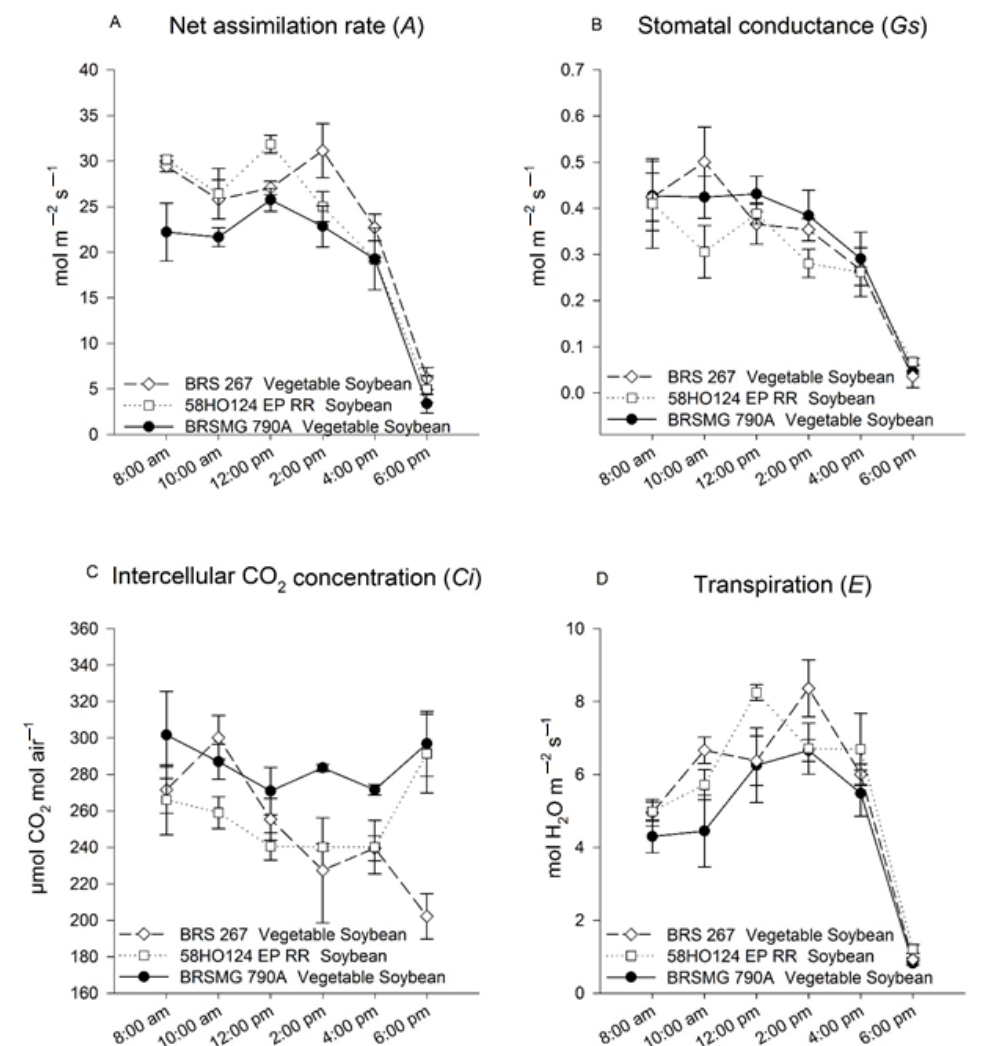
Figure 1. Net CO 2 assimilation rate ( A , μ mol m − 2 s − 1 ) ( A ), stomatal conductance ( Gs , mol m − 2 s − 1 ) ( B ), intercellular CO 2 concentration ( Ci , μ mol CO 2 mol air − 1 ) ( C ), and transpiration ( E , mol H 2 O m − 2 s − 1 ) ( D ) of vegetable and conventional soybean cultivars. Botucatu, SP, Brazil, 2021.